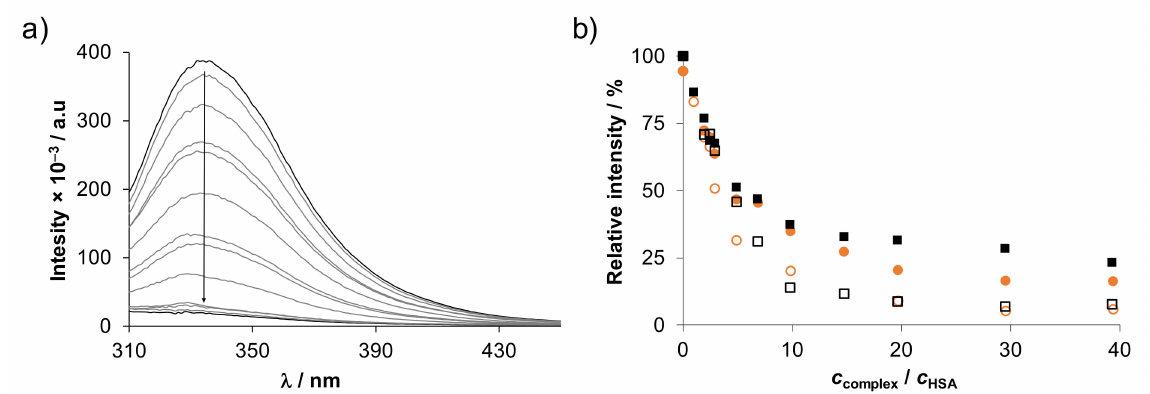
Figure 10. ( a ) Fluorescence emission spectra recorded for HSA upon addition of various amount of RhCp*–HQCl-D-hPro complex using λ EX = 295 nm. ( b ) Intensity changes at 330 nm plotted against c complex / c HSA ratio. Symbols for the complexes: RhCp*–HQCl-D-Pro ( (cid:3) ), RhCp*–HQCl-D-hPro (